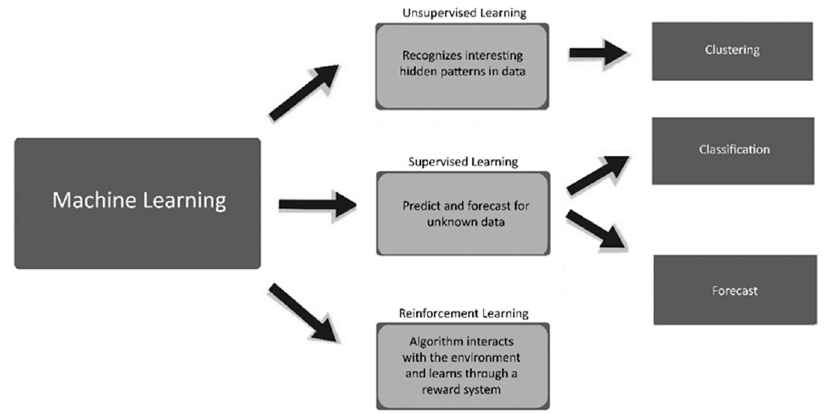
Figure 4. General classification of machine learning algorithms.